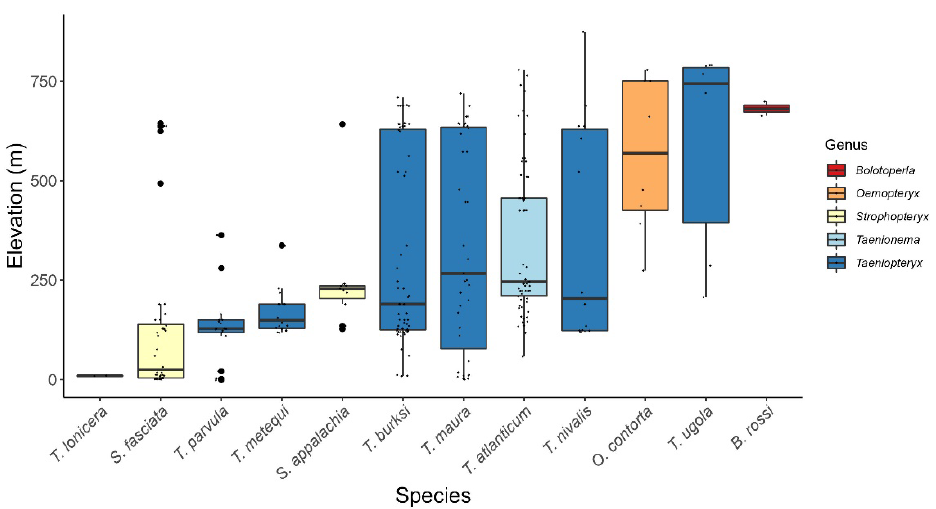
19 Figure 14. Elevation boxplots for Pteronarcyidae species recorded from Maryland. Boxes represent the interquartile range, while vertical lines extend to the minimum and maximum values. The horizontal line within the interquartile range represents the median elevation. Outliers are shown with large, solid circles. Small, individual points overlaid on each boxplot illustrate the distribution of observations. 3.6.9. Taeniopterygidae Adults have been collected from late December to mid-May and from low to high